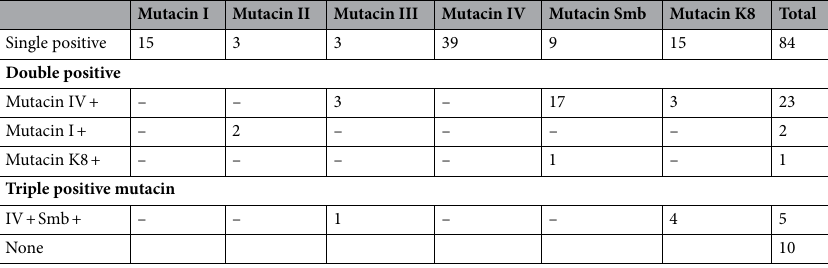
Table 1. The number of strains by the type of the retention with bacteriocin genes.